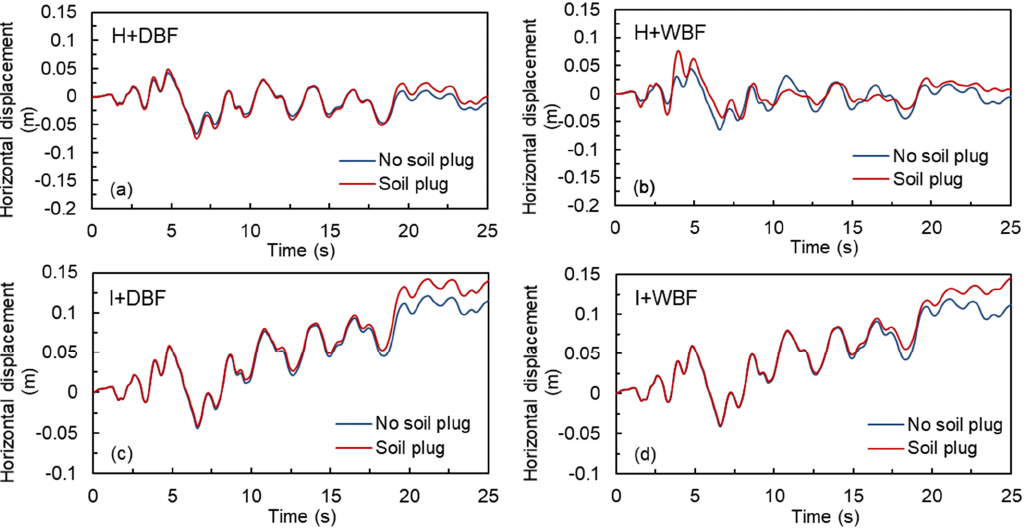
Figure 7. The horizontal displacement time histories at the top of the bucket foundations in 50% relative density liquefiable seabed: ( a ) deep bucket foundation (DBF) in horizontal liquefiable seabed; ( b ) wide bucket foundation (WBF) in horizontal liquefiable seabed; ( c ) deep bucket foundation (DBF) in inclined liquefiable seabed; ( d ) wide bucket foundation (WBF) in inclined liquefiable seabed. H refers to horizontal seabed and I refers to inclined seabed.